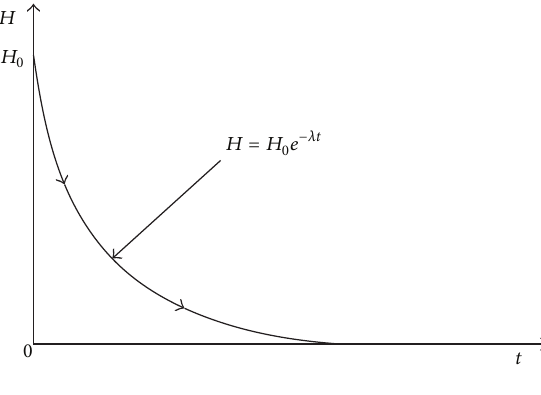
Figure 8: Exponential evolution